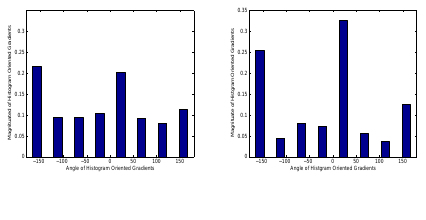
Fig. 1. CHOG of different